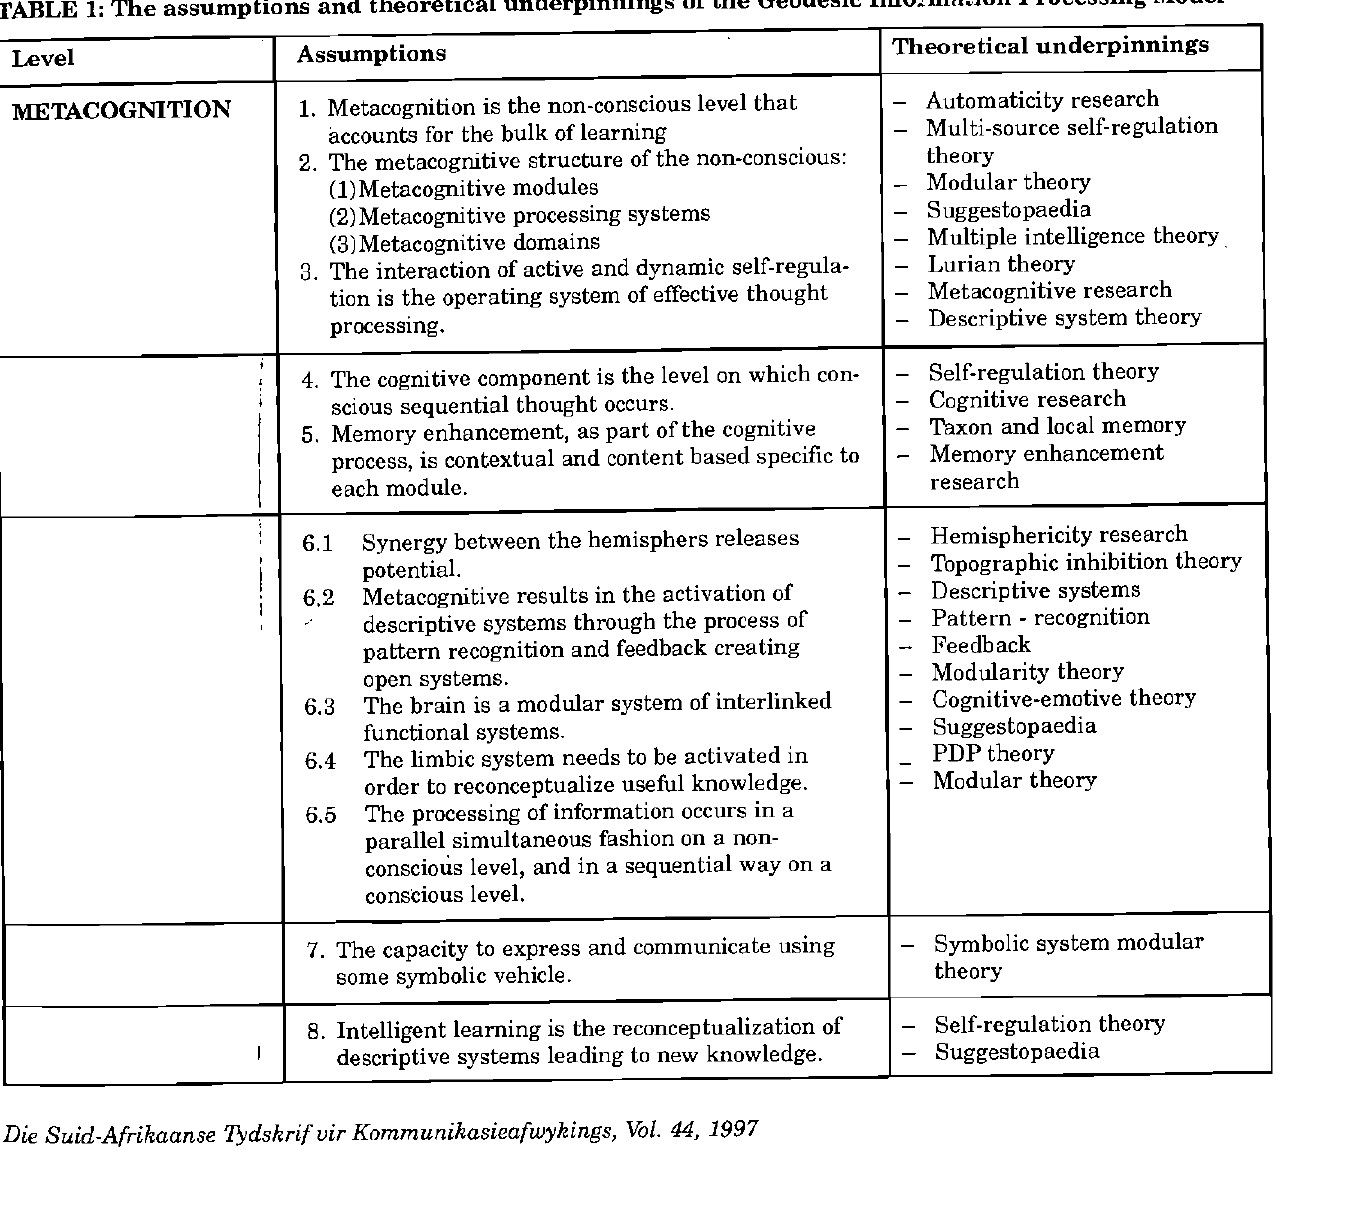
TABLE 1: The assumptions and theoretical underpinnings of the Geodesic Information Processing Model Level Assumptions